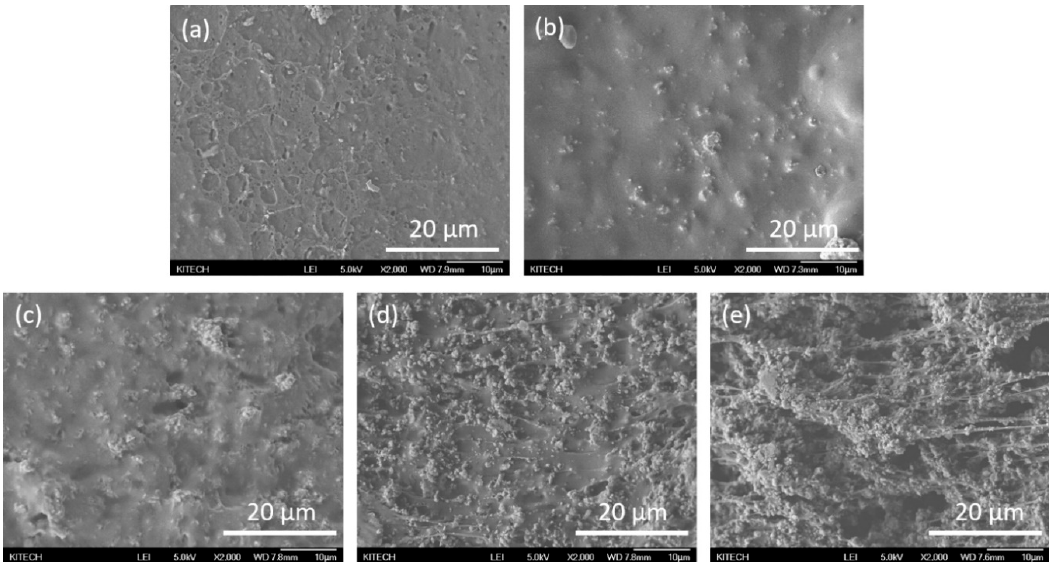
Figure 5. SEM images of the fractured surfaces of the UiO-66/DSPD composite films with ( a ) 0, ( b ) 6.5, ( c ) 15.3, ( d ) 32.4, and ( e ) 49.5 wt.% UiO-66 contents. Magnification is 2000.